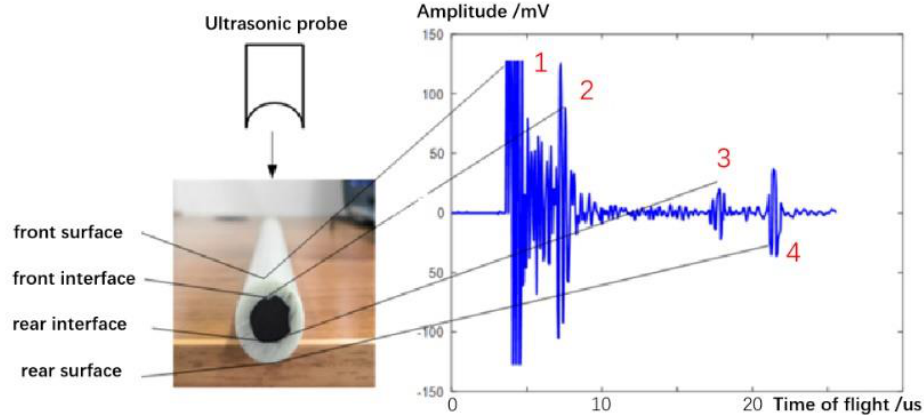
Figure 6. Ultrasonic pulse-echo signal of carbon fiber rod with no defect.